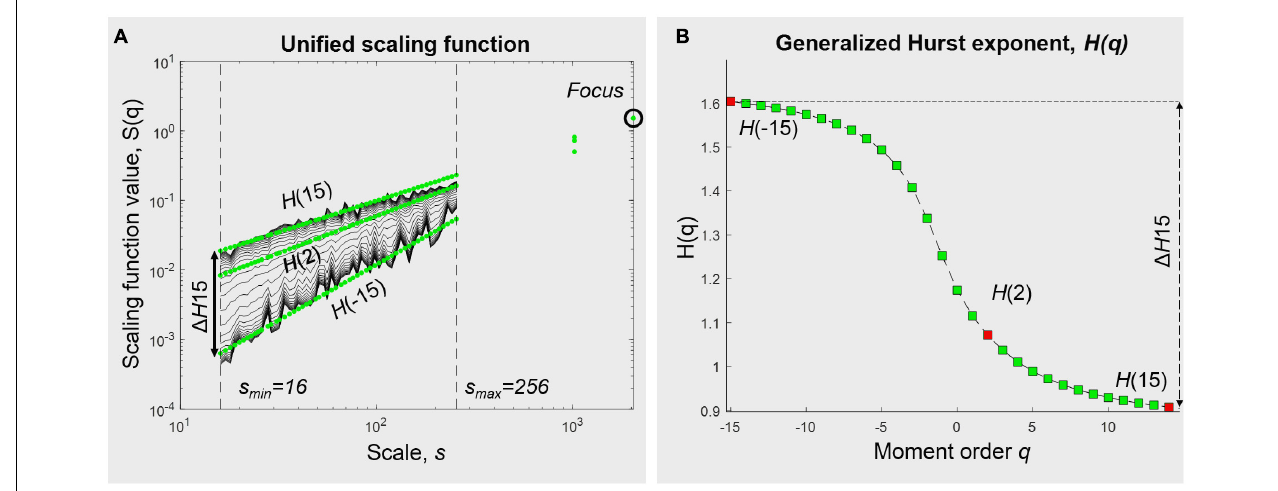
FIGURE 3 | Multifractal analysis of hand movement time series (in this example, in UVF with the dominant hand). (A) Unified scaling function from a focus-based multifractal DFA analysis. (B) Generalized Hurst exponent, obtained from linear regression over statistical moments q . In some extent, H(2) represents the monofractal exponent (see Section “Multifractality in Hand Displacement Time Series”). The degree of multifractality (cid:49) H15 is calculated as the difference between H(–15) and